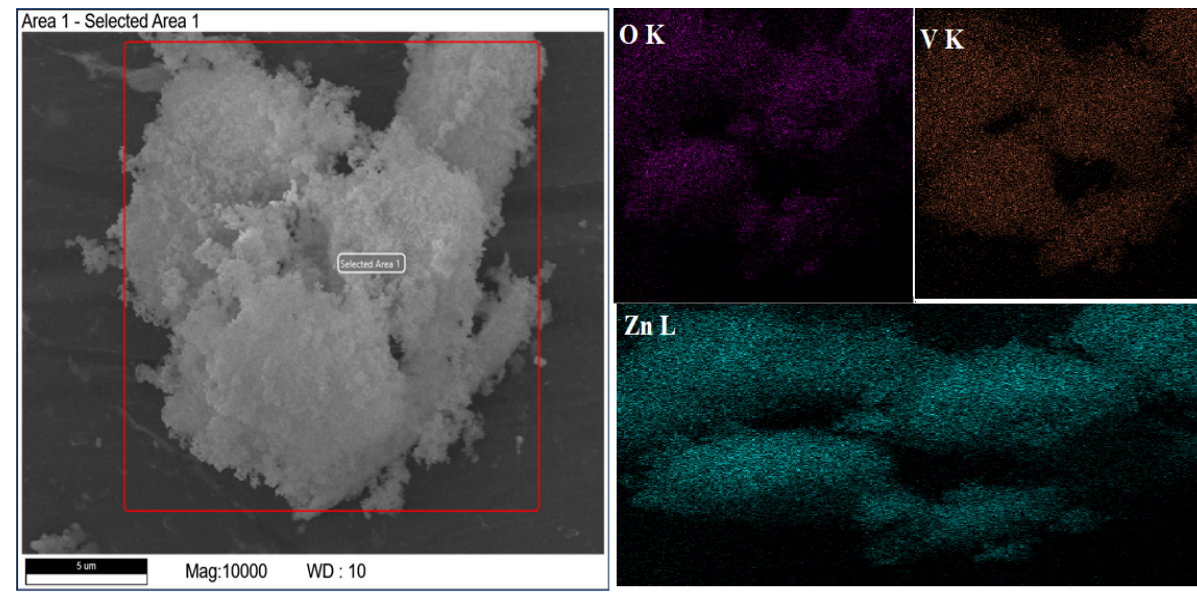
Figure 4. Elemental mapping of ZV.